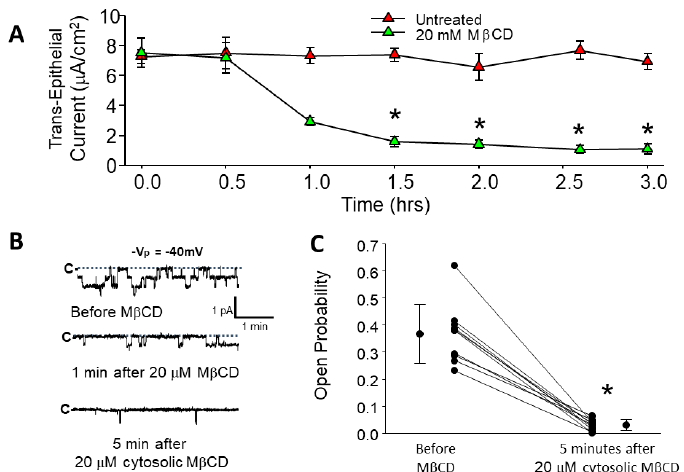
Figure 5. Sensitivity to methyl- β -cyclodextrin (M β CD) is asymmetric. ( A ) To inhibit sodium transport in cells in monolayer cultures on permeable supports required treatment with high concentrations (20 mM) of M β CD on the apical surface. * indicates significant difference from untreated. ( B ) In contrast, low concentrations of M β CD on the cytosolic surface of an excised, cell-free patch treated with 20 μ M PIP 2 rapidly reduces ENaC P o in excised, cell-free patches. We excised membrane patches from mpkCCD cells in the presence of 20 µ M PIP 2 and applied 20 µ M M β CD to the cytosolic surface of the membrane, where it presumably would have direct access to the cholesterol in the inner leaflet of lipid rafts. ( C ) At a concentration 1000 times lower than what we had applied to the luminal surface (20 µ M instead of 20 mM), we could reduce ENaC open probability close to zero in less than 5 min ( p < 0.001, paired t -test n = 7 where symbols represent individual